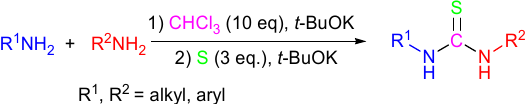
Scheme 25. Reaction of amines with sulfur and chloroform as a route to thioureas